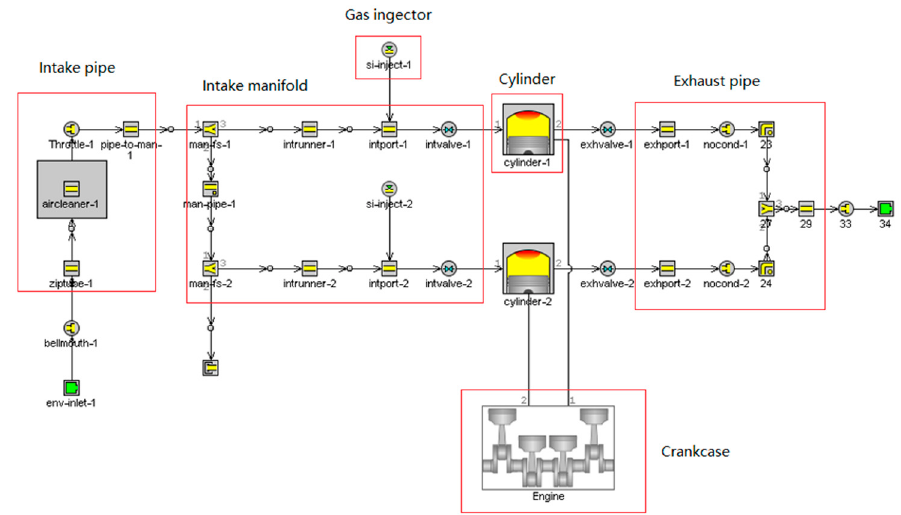
Figure 1. GT Power model for Engine A.